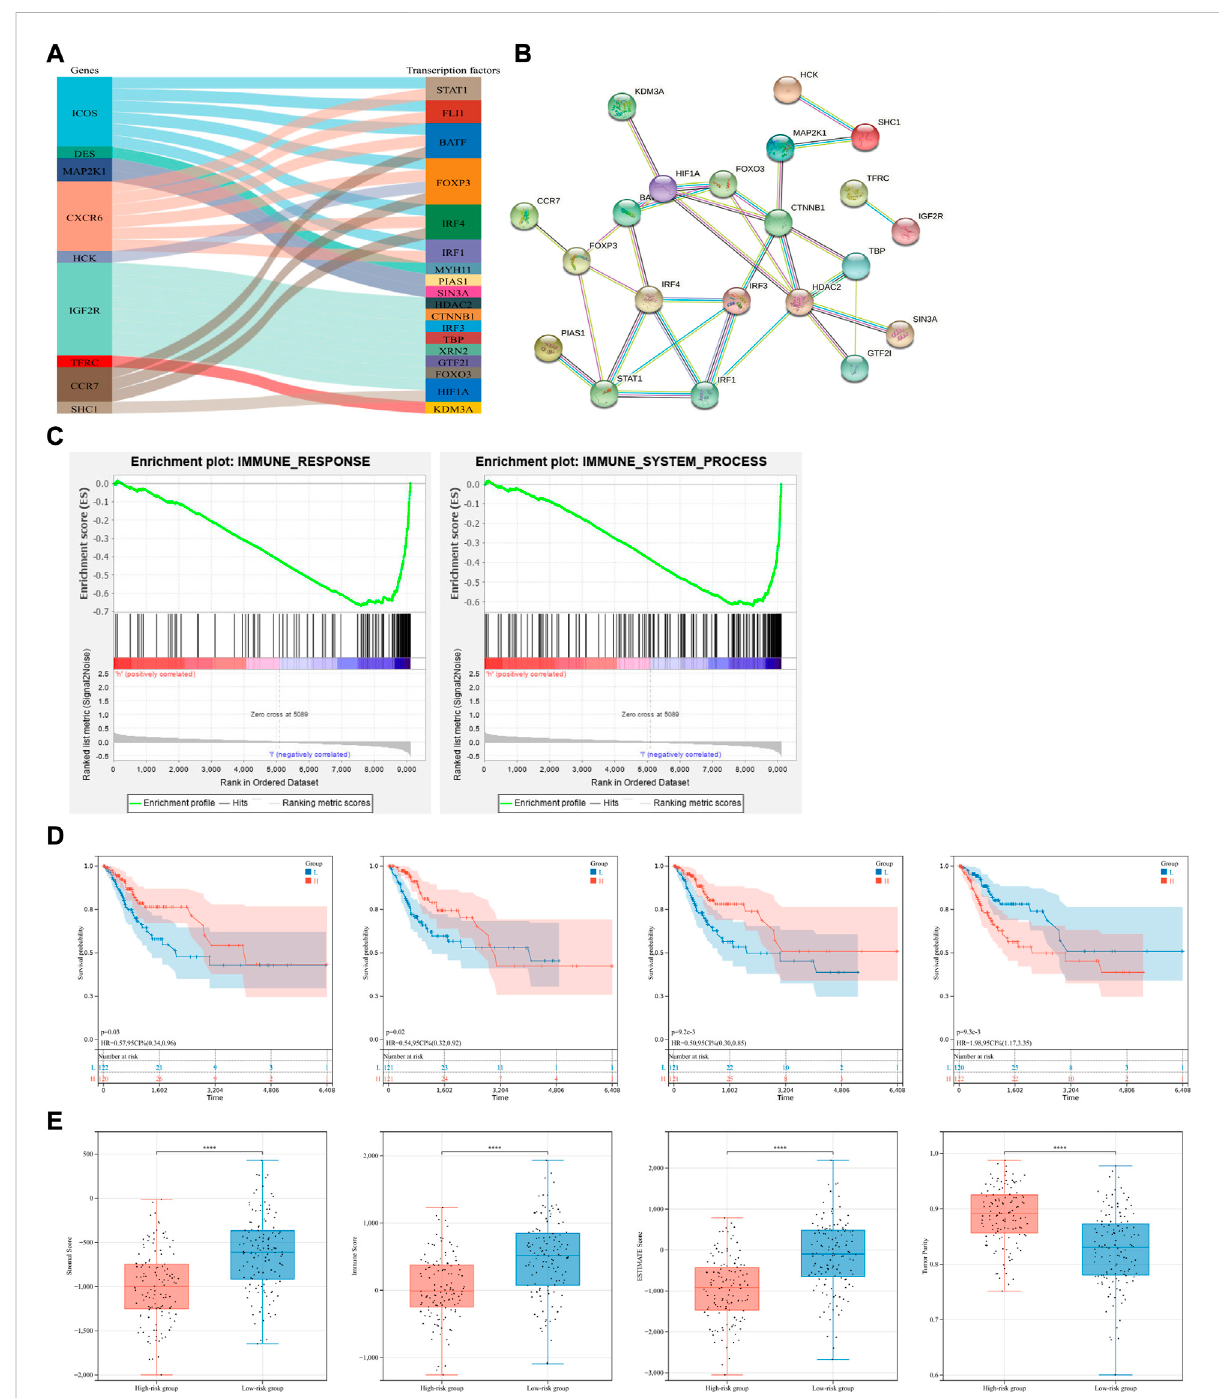
FIGURE 5 Transcription factors, functional annotation of the signature and exploration of tumor immune microenvironment. (A,B) TFs exploration and their regulatory relationship of seven candidate genes. (C) Gene Set Enrichment Analysis (GSEA) in the whole TCGA-CSCC set. Enriched immune response (left)and immune system process (right)pathwaysbetween thehigh- andlow-risk groupswereshown. (D) Conductionof survival analysis to assess the prognosis of patients with different scores of stromal cells, immune cells, ESTIMATE and tumor purity (from left to right). (E) The status ofimmune microenvironment indifferentriskgroup, stromal, immune,ESTIMATEscores and tumor purity werecompared(from leftto